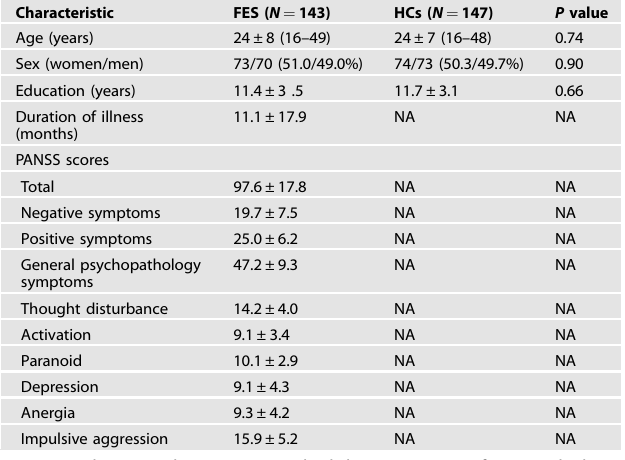
Table 1. Demographic and clinical characteristics of antipsychotic- naïve fi rst-episode schizophrenia and healthy